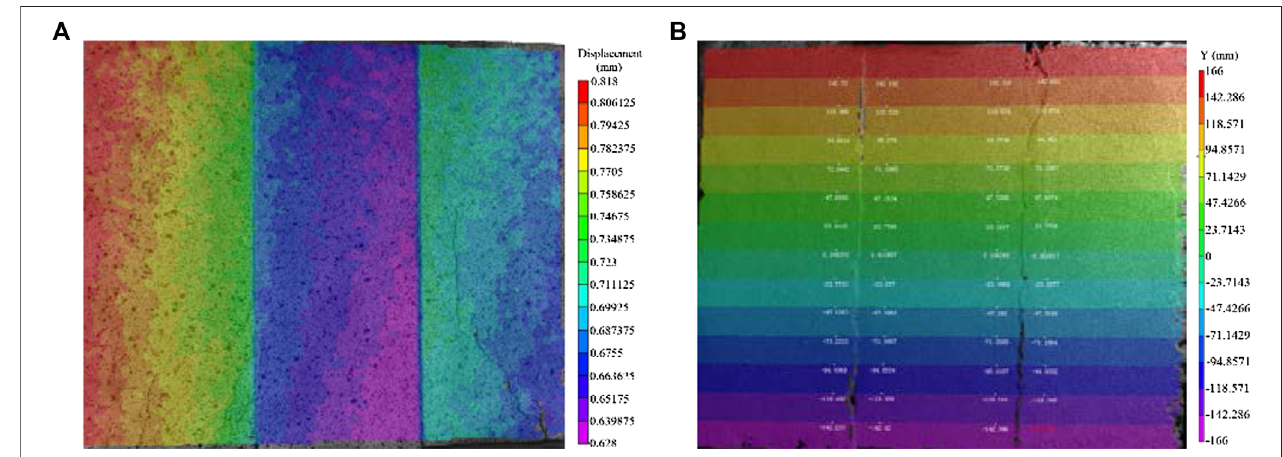
FIGURE 13 | Test results and post-processing methods based on digital image correlation. (A) The cloud picture of slip. (B) Selection of analysis points near the interface.